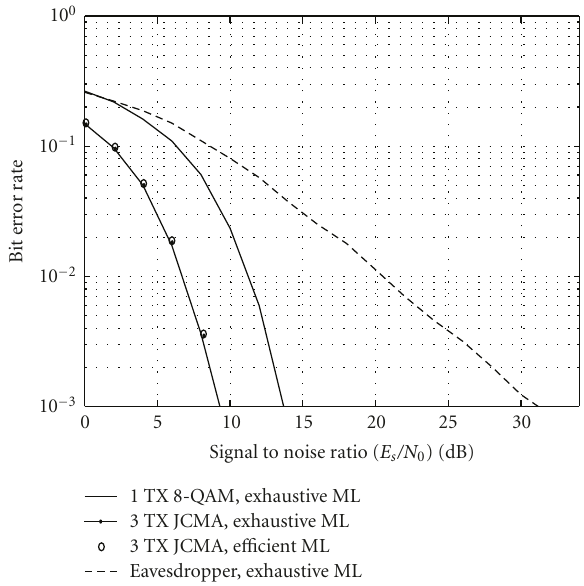
Figure 5. Each set of 3 bits represents the bits of TX1, TX2, and TX3 from left to right, respectively. Notice that the average energy of the received constellation is larger than 1.